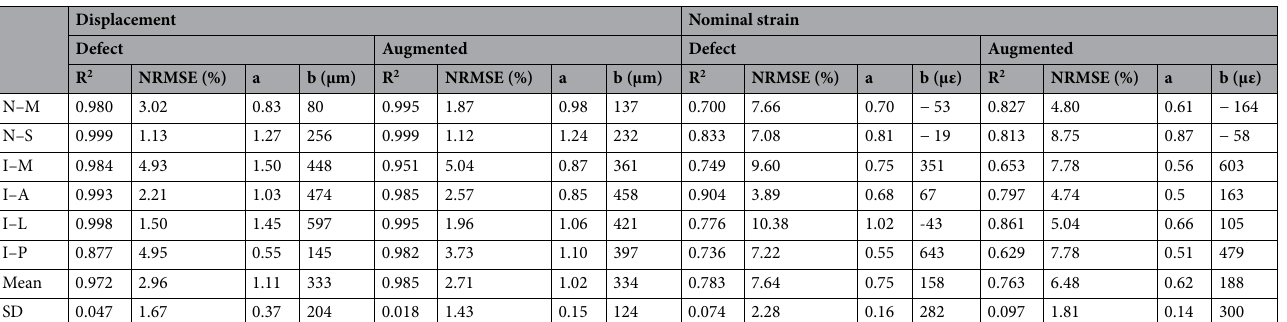
Table 2. Summary of the linear regression results for the displacement and nominal strain comparisons between FE and DIC results. a = slope; b = intercept. The abbreviations on the left refer to the location of the lesion in the tested femurs (see Table 1).